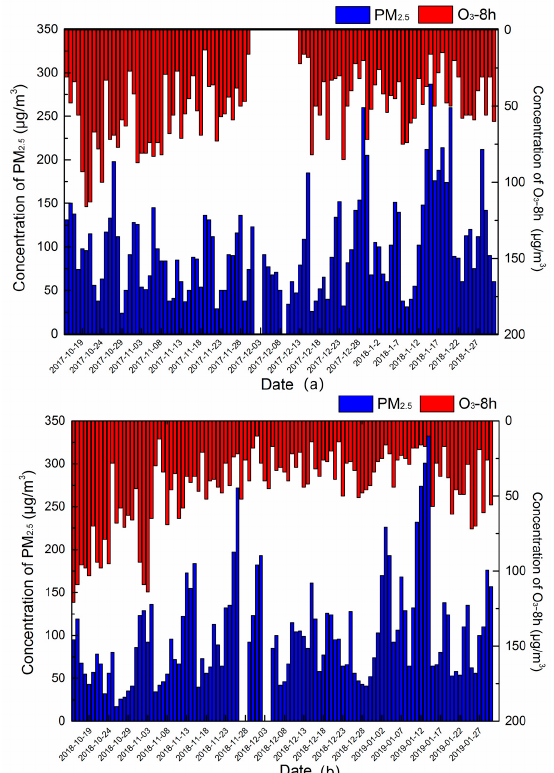
Figure 5. Concentration of PM 2.5 and O 3 -8h at the autumn–winter seasons of 2017–2018 ( a ) and 2018–2019 ( b ).